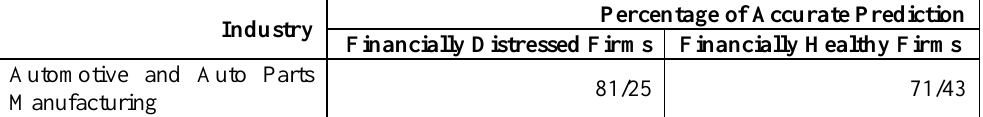
Table (8). Accuracy of Final Model for Predicting Corporate Default in the Group of Financially Distressed and Healthy